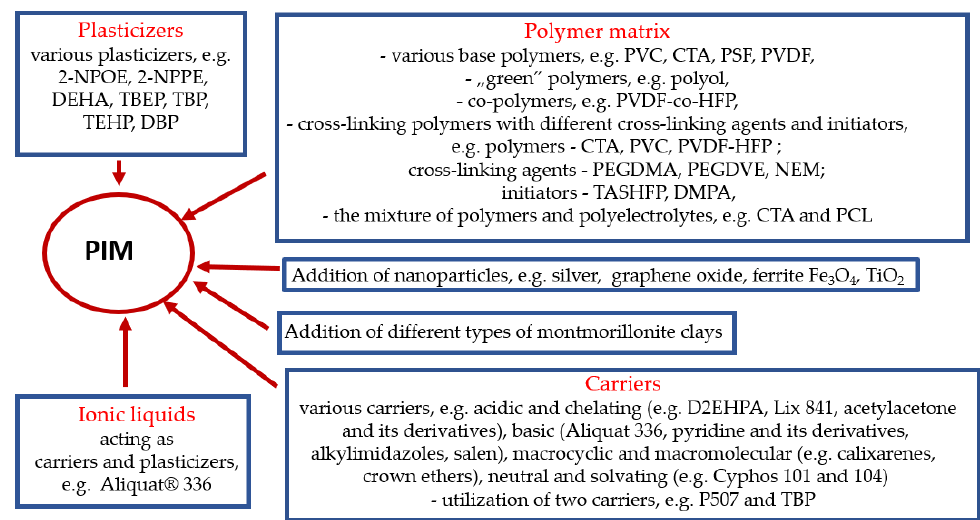
Figure 3. The main modifications made over the past three years during the formulation of